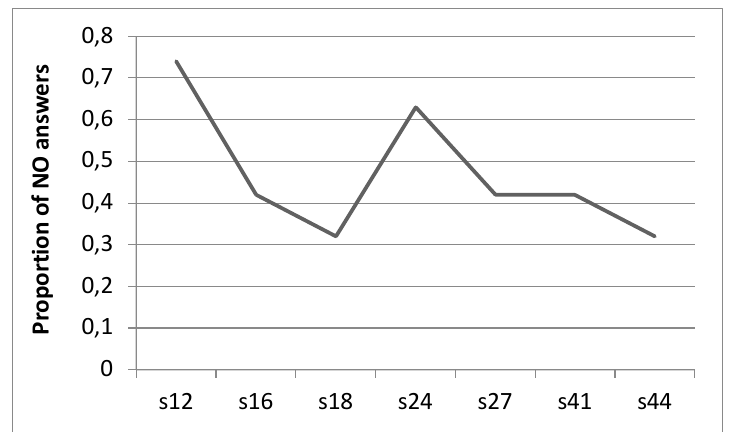
Graphic 7 . Proportion of expected answers for convencer -sentences along the